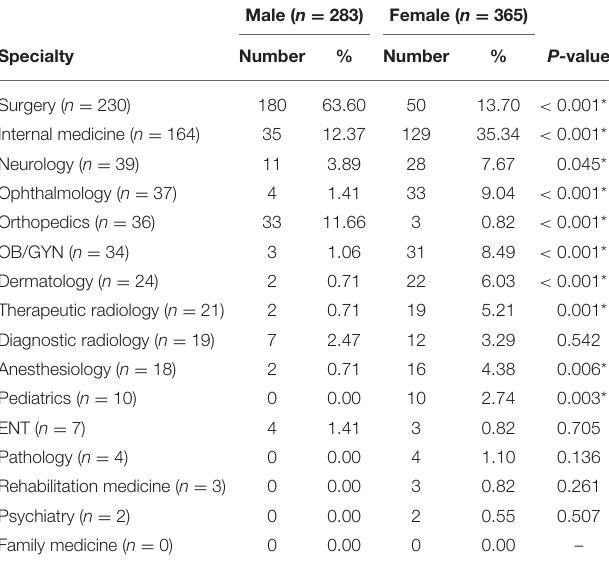
TABLE 1 | Specialty choices of 648 Chinese medical